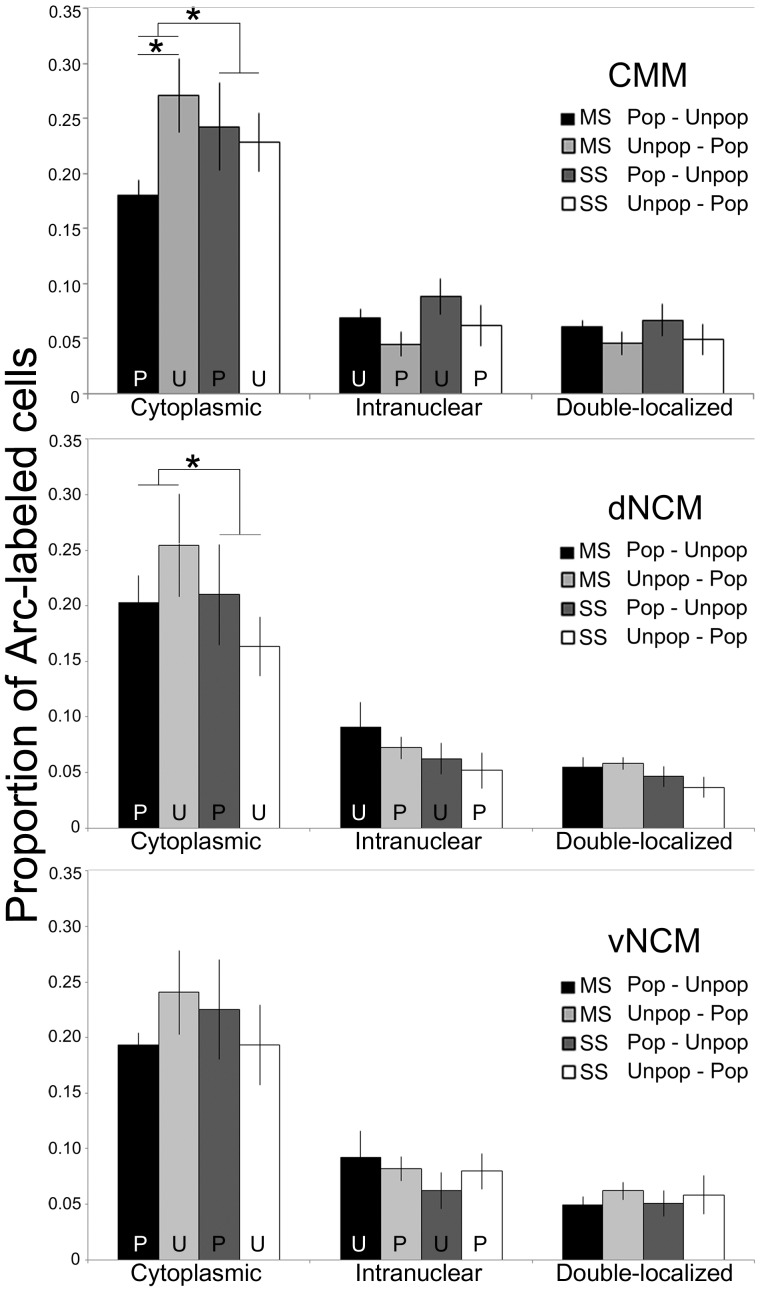
catFISH results from CMM, dNCM, and vNCM.Bars show the normalized proportion of cells with cytoplasmic, intranuclear, or double-localized Arc mRNA. For clarity, “U” and “P” indicate that either Unpopular or Popular song playbacks induced the cytoplasmic and intranuclear staining in the four conditions. Asterisks denote significant (p<0.05) differences. Error bars indicate s.e.m.